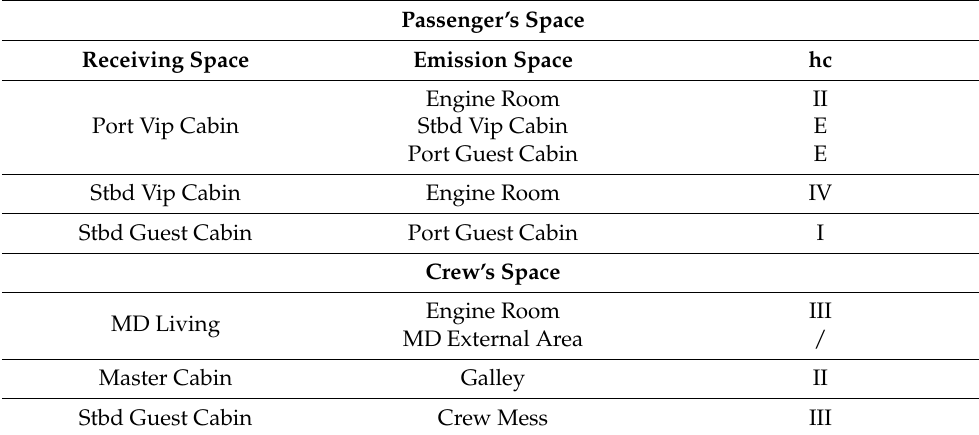
Table 8. Standardized level difference with the Germanischer Lloyd classification.